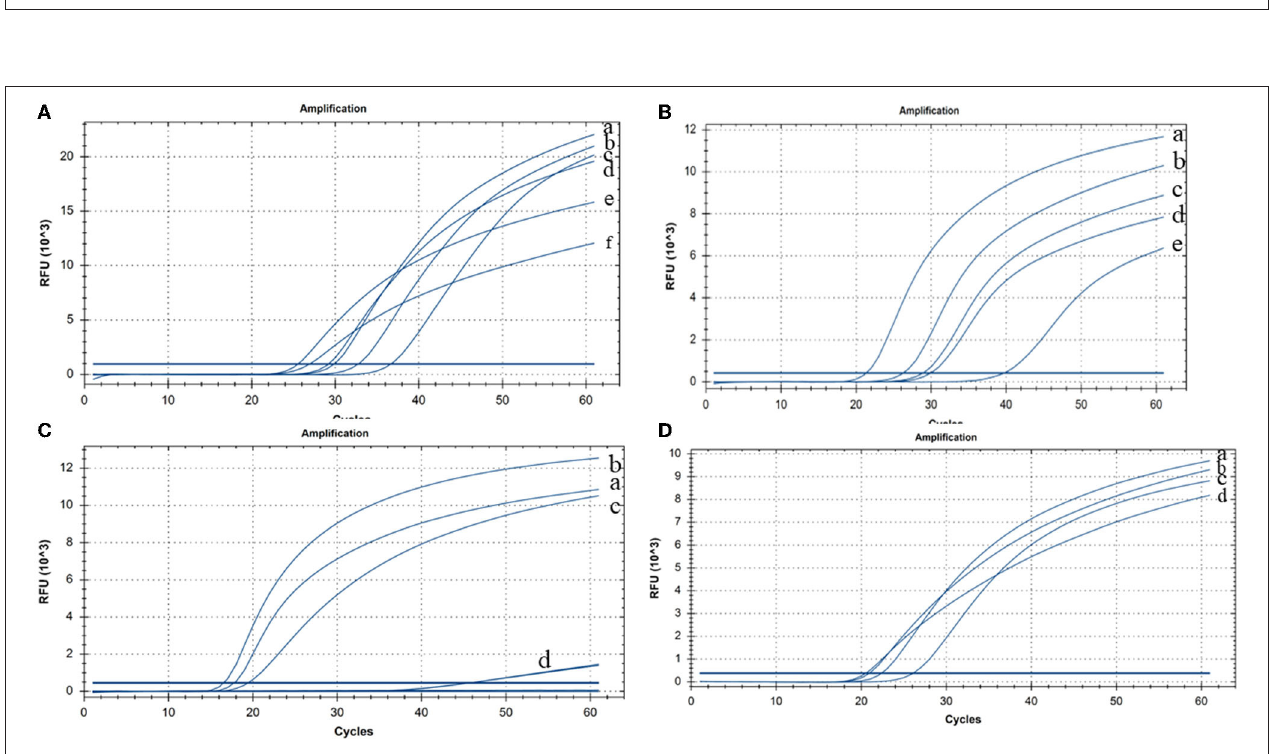
FIGURE 2 | Cleaved probe-based reverse transcription loop-mediated isothermal amplification (CP-RT-LAMP) assay optimization (A) Temperature: (a) 63 ◦ C, (b) 61 ◦ C, (c) 62 ◦ C, (d) 60 ◦ C, (e) 64 ◦ C, and (f) 65 ◦ C. (B) Concentration of dNTPs: (a) 2.4mM, (b) 2mM, (c) 1.6mM, (d) 1.4mM, and (e) 1.2mM. (C) Concentration of MgSO 4 : (a) 8mM, (b) 6mM, (c) 4mM, and (d) 2mM. (D) Concentration of the loop primer probe: (a) 0.08 µ M, (b) 0.12 µ M, (c) 0.04 µ M, and (d) 0.16 µ M.